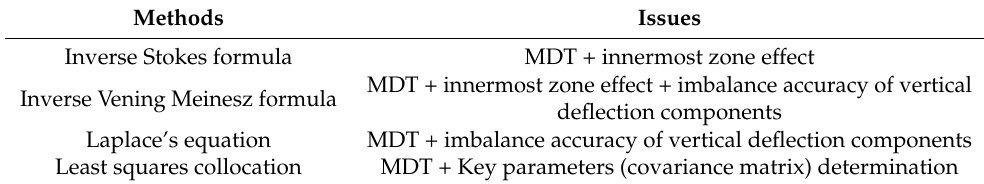
Table 1. Several methods impacted by different